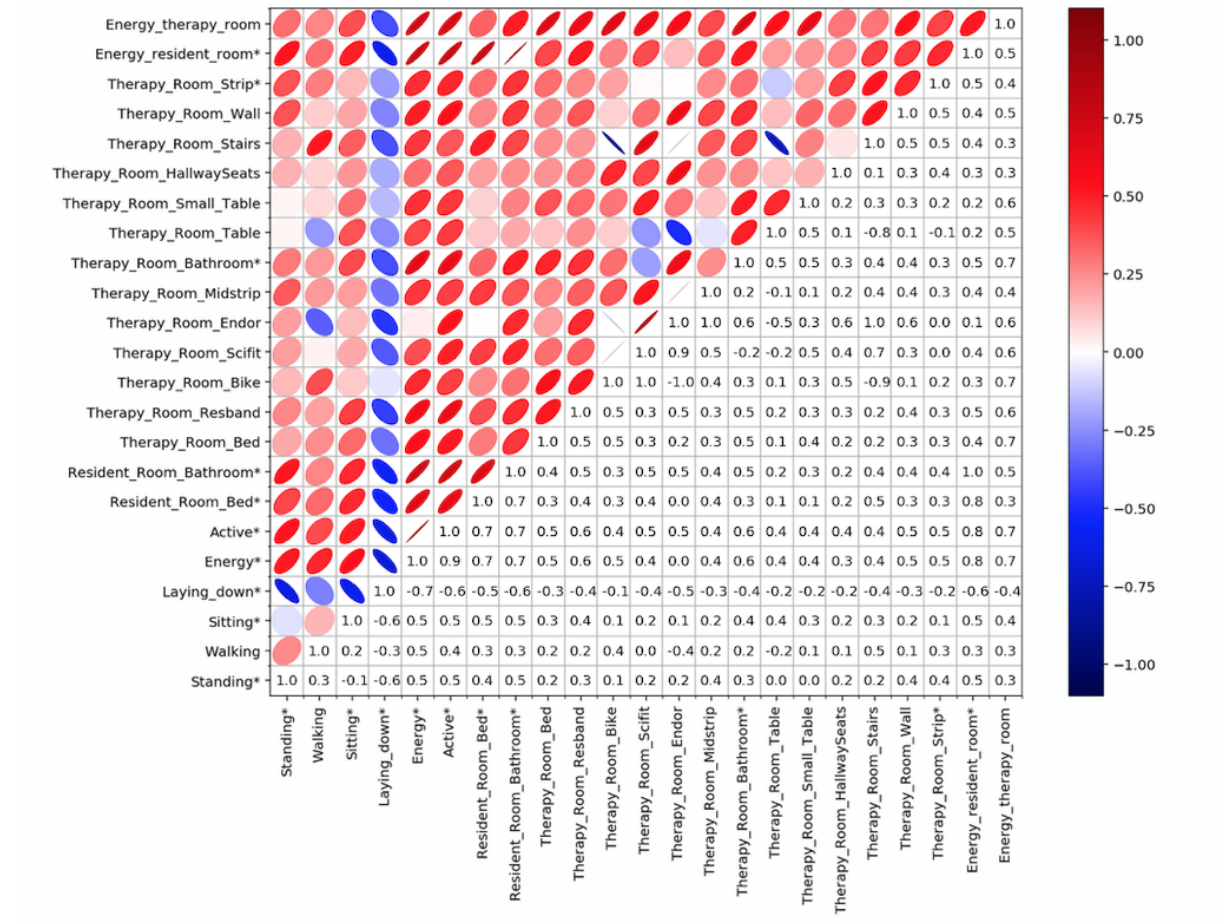
Figure 9. Correlations among sensor-based features. Asterisk indicates parameters with P <.05.